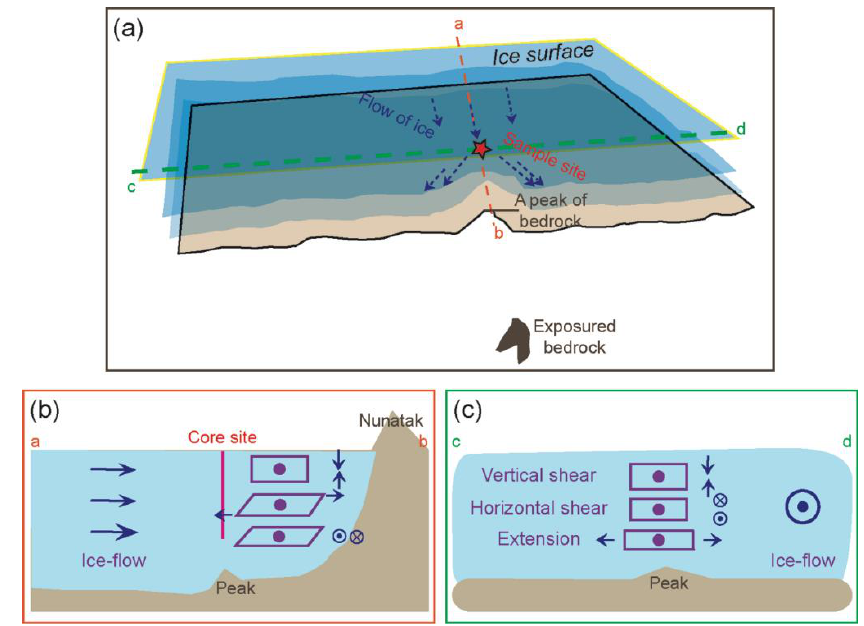
Figure 10. Schematic views of ( a ) sample location with flow of ice, ( b ) a cross section of a–b (marked as the orange line) in ( a ), and ( c ) a cross section (presented as the green line) of c–d in ( a ). The diverse stress regimes at different depths may be the results of the low velocity of ice flow, and a nunatak located ~4 km to the southease (SE) from the study area.